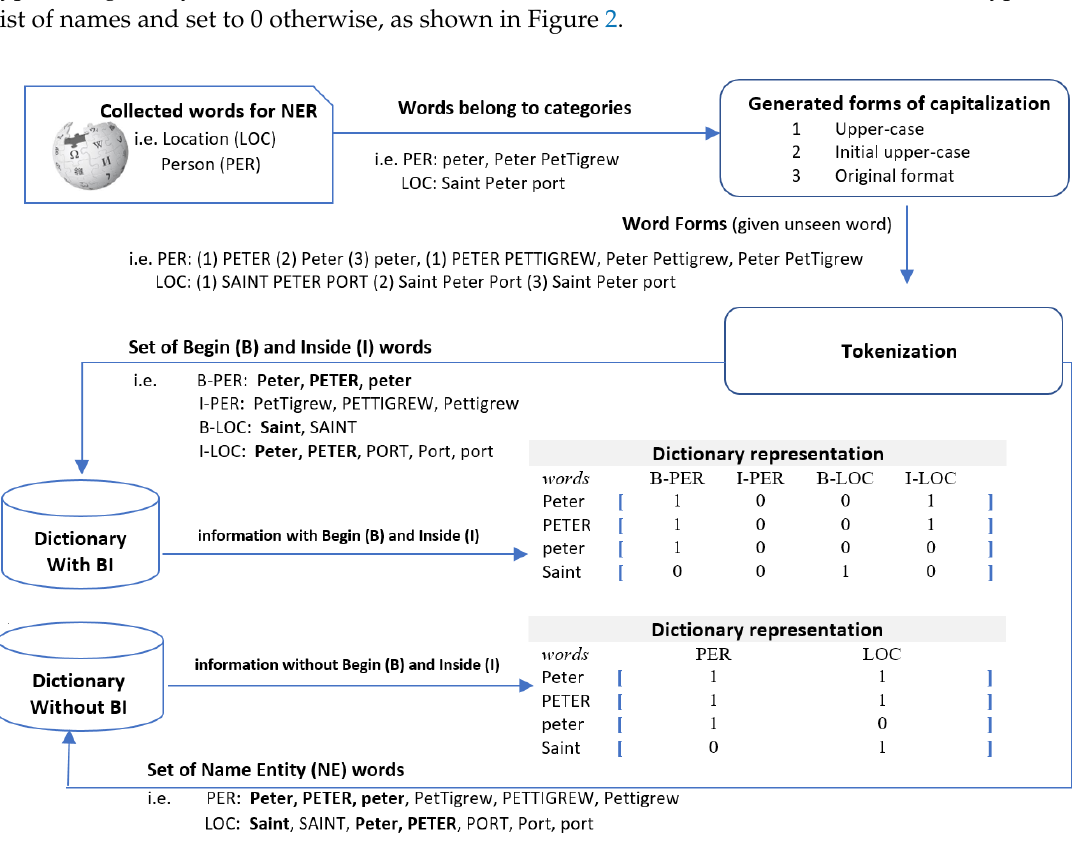
Figure 2. The process of dictionary building: (1) gather named entities from various sources, (2) generate capitalization variants of each names, (3) tokenize and classify with types and word positions, and (4) construct a dictionary using binary notation. The numbers 0 and 1 denote the status of found (1) and not found (0) in each